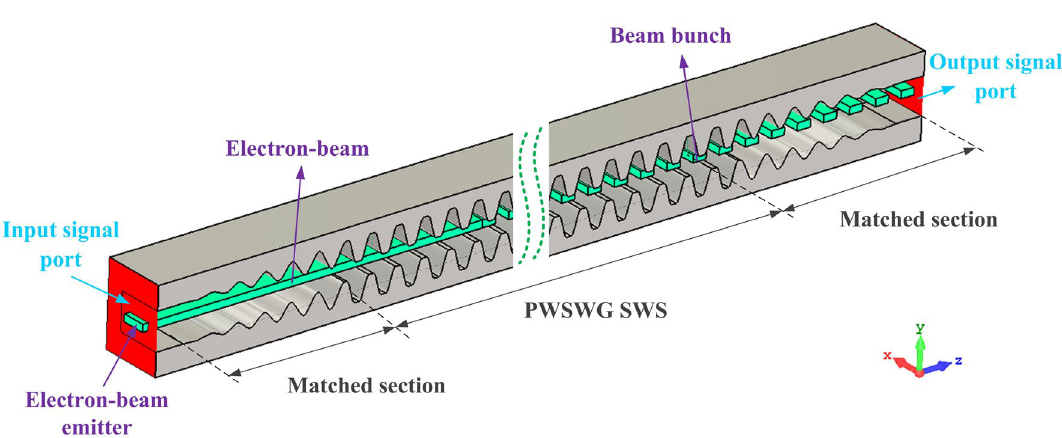
Figure 12. 3D Particle-in-cell simulation model of the PWSWG TWT in CST